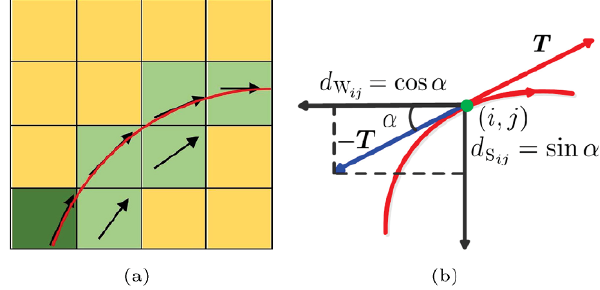
Fig. 8 Design of the direction coefficients. (a) Diffusion route (red curve) is specified by users with diffusion directions (indicated by black arrows). (b) The direction coefficient is calculated by reversing the unit tangent vector T , and projecting the reversed tangent vector − T to corresponding directions.